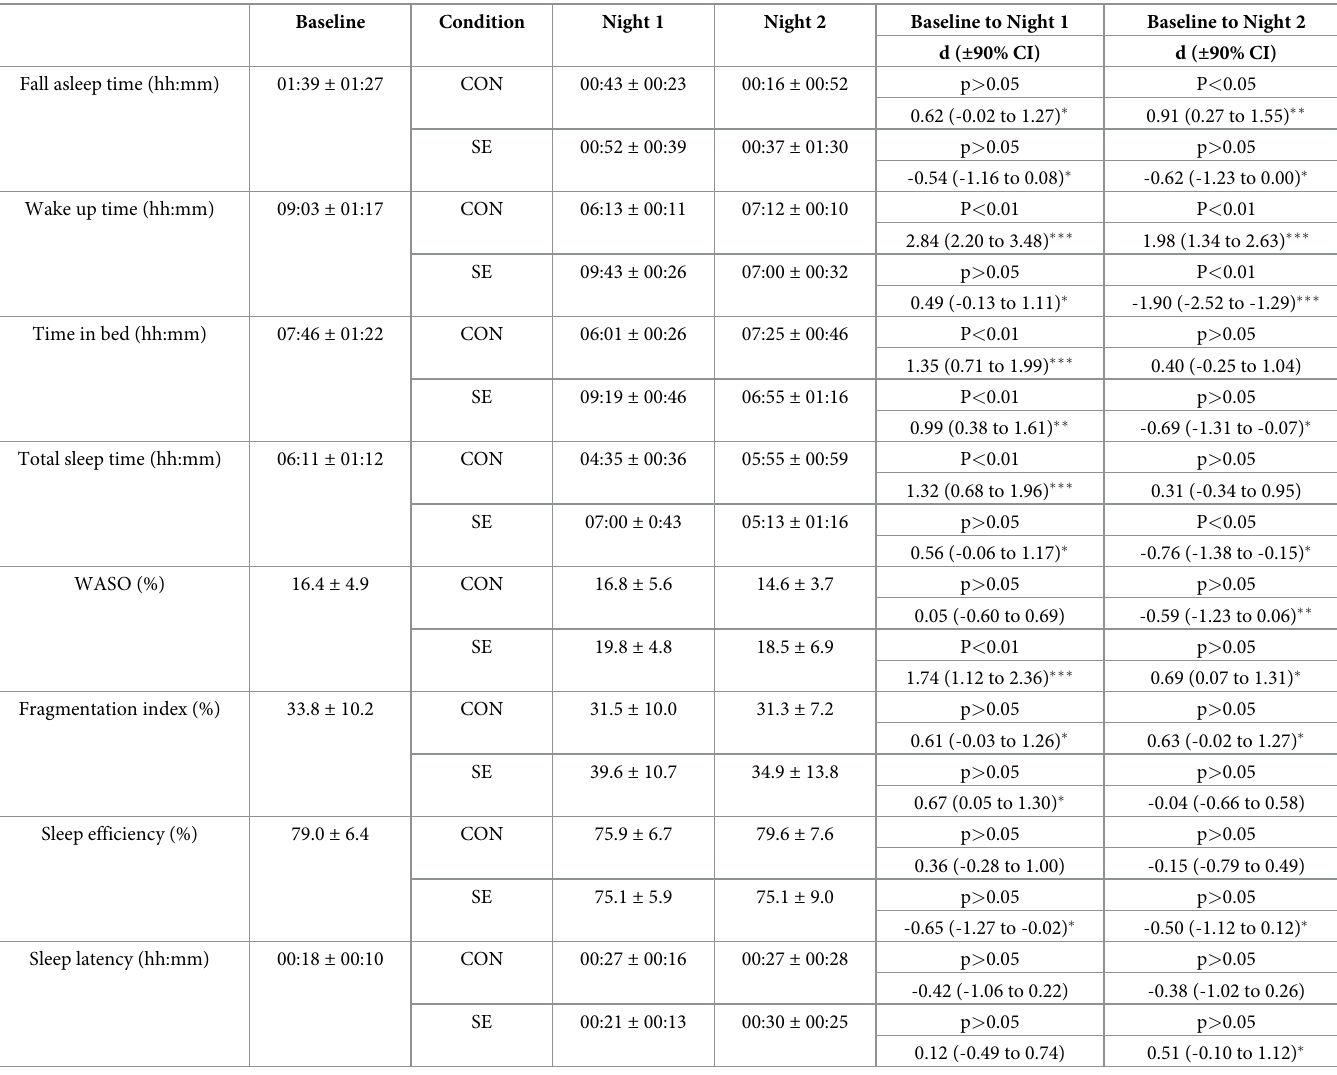
Table 3. Sleep parameters during baseline, night 1 and 2. Baseline Condition Night 1 Night 2 Baseline to Night 1 Baseline to Night 2